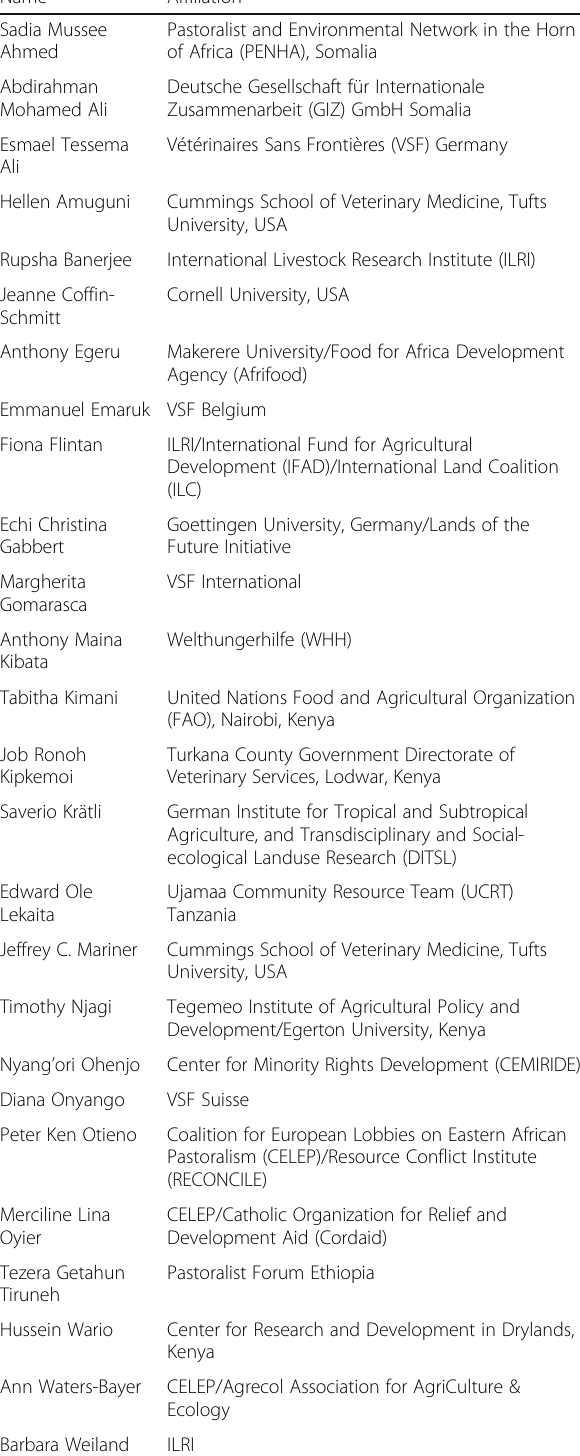
Table 1 Experts consulted for this paper and their affiliations